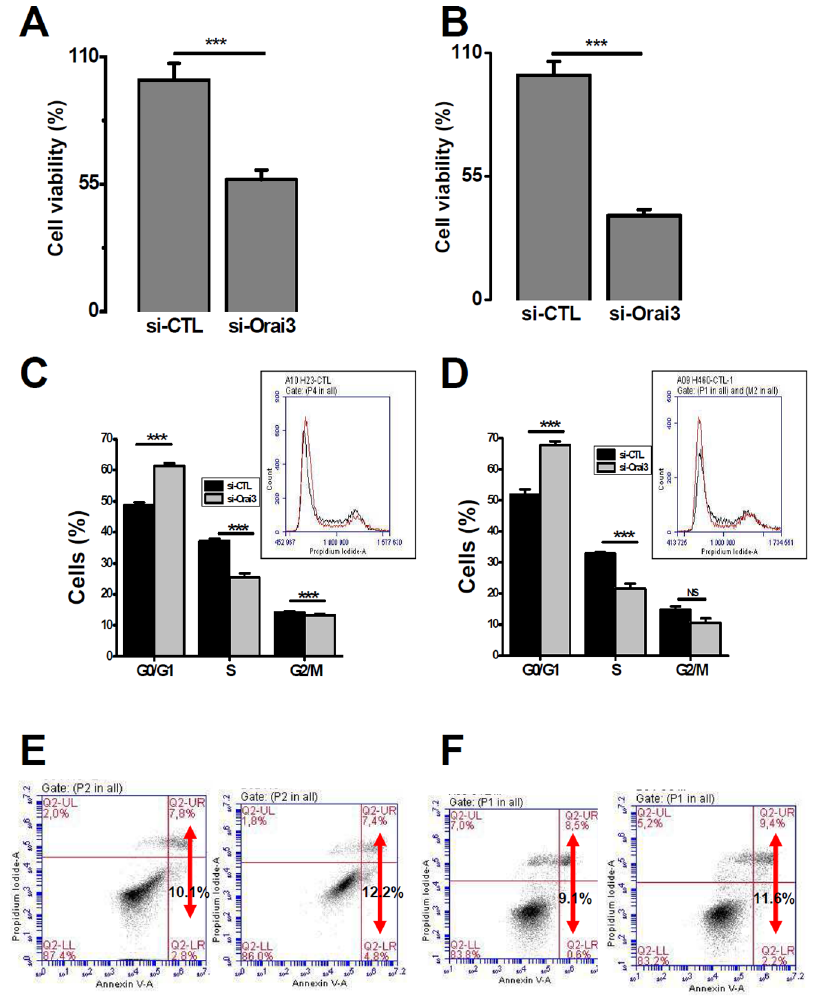
Figure 5. Down regulation of Orai3 reduced cell proliferation and arrested cells in G0/G1 phase. A, Effect of Orai3-knockdown on NCI- H23 cell viability (*** p , 0.001, t-test ). B, The same experiments were carried on NCI-H460 cells (*** p , 0.001, t-test ). Cell viability was measured 72-h post-transfection and was normalized as a percentage of the control and results were expressed as mean 6 SEM of three independent experiments. C–D, a cell-cycle distribution of NCI-H23 (C) and NCI-H460 (D) cells transfected with si-Orai3 or si-CTL carried out by flow cytometry of the cells stained with Propidium Iodide. Inserts : traces representing distribution of the cells in the cell cycle. Asterisks denote statistical significance as compared to control cells; *** p , 0.001 of three independent experiments (t-test). E–F, An apoptosis assay carried out by Annexin V staining. Orai3 silencing failed to affect NCI-H23 (E) and NCI-H460 (F) apoptosis.